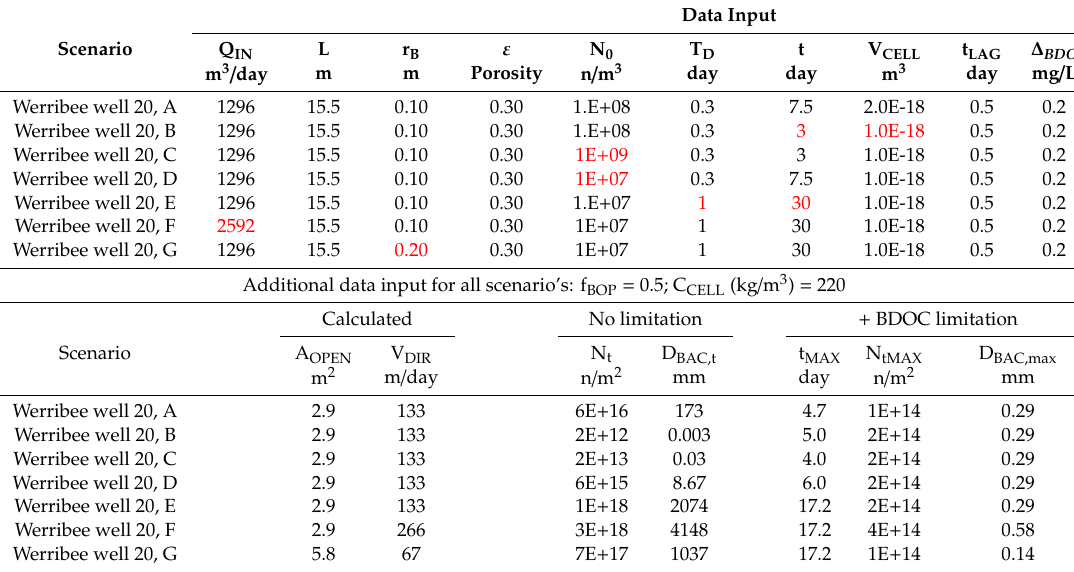
Table 8. Predicted unlimited growth of bacteria (N t –N 0 ) according to Equation (8) and carbon limited growth of bacteria (N tMAX –N 0 ) according to Equation (11), and their clogging of open pore space on the borehole wall in terms of thickness of biofouled layer (D BAC,t and D BAC,max ; Equation (9)). Also shown is t MAX (Equation (14); time since start of exponential bacterial growth to the maximum level of growth) assuming that carbon supply (with ∆ BDOC as indicator) for bacterial growth is the limiting factor. Explanations of parameters in Section 2.7. Red numbers = significant scenario changes.